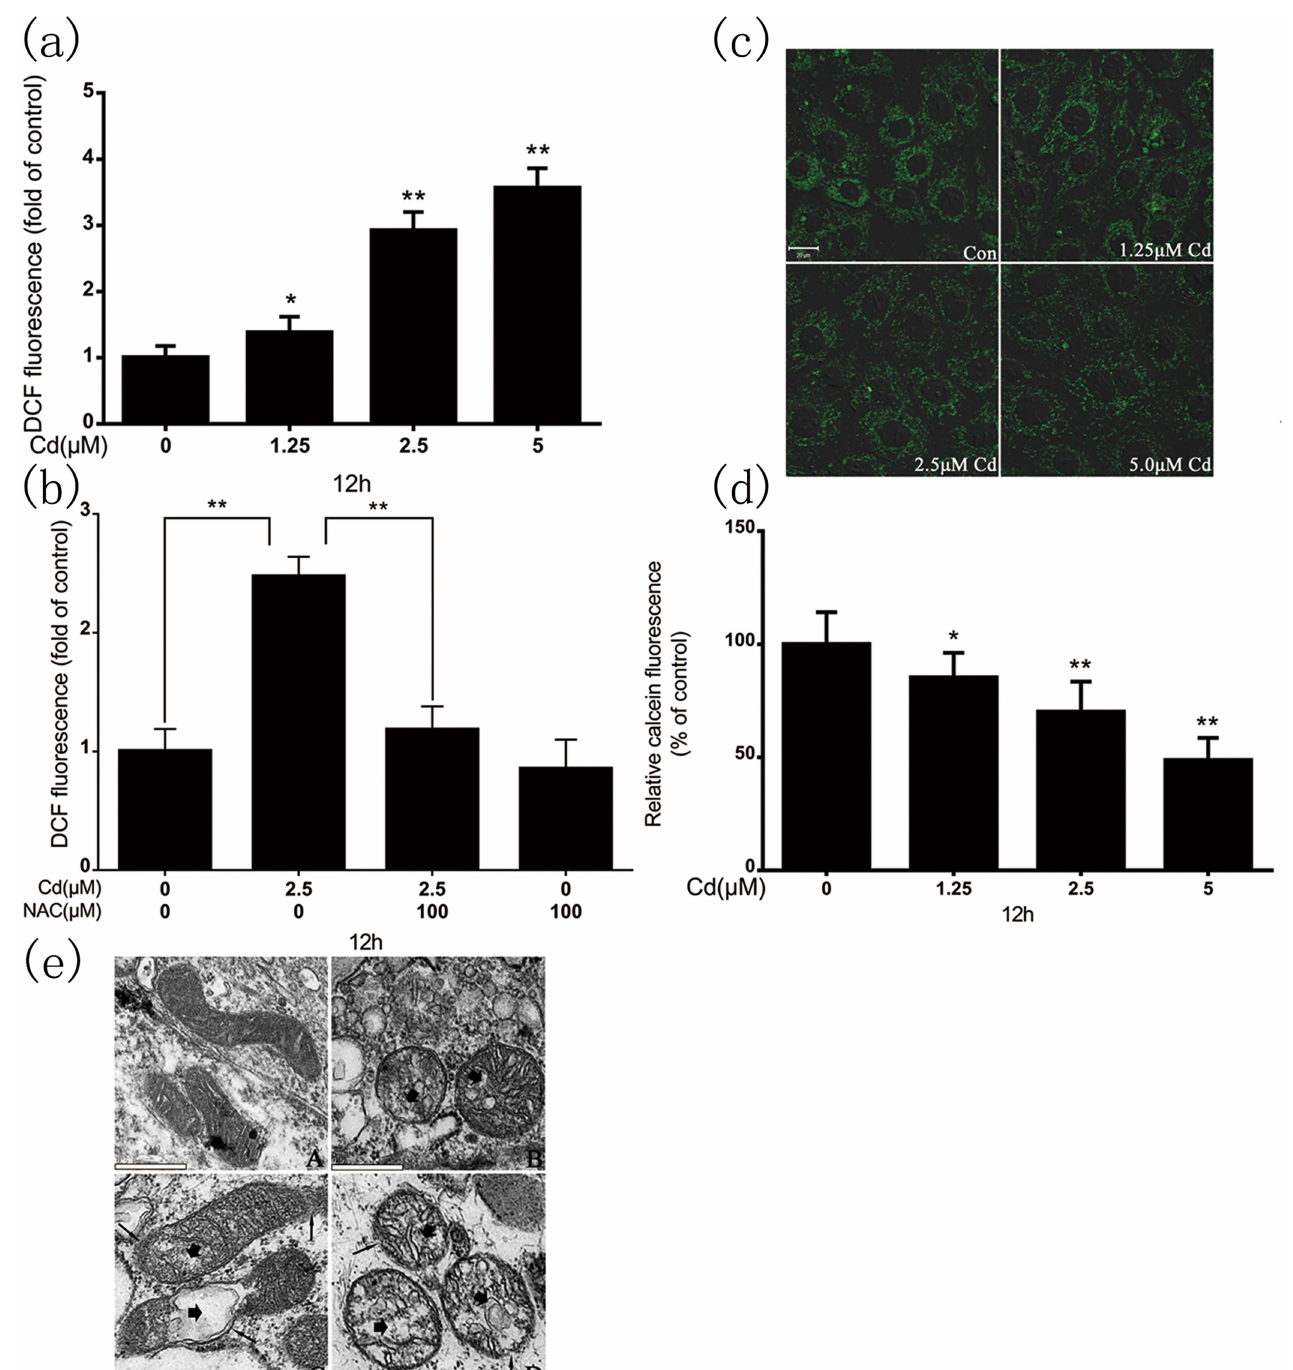
Fig 1. (a) Cadmium inducedROS generationdose-dependently in rPT cells. (b) Intracellular ROS levels in rPT cells after 12-h cadmium(2.5 μ M) treatment in the absenceor presence of NAC (100 μ M). DCF fluorescence was measuredusing a flow cytometer with FL-1 filter. Confocal microscopyof cadmium-inducedMPTP opening.(c) Representative confocalimages of cadmium-inducedrPT cells. (d) Quantification of calcein fluorescence. Calceinfluorescence values were quantifiedrelative to the control, where the fluorescence value was set at 100%. (e) Representative electron micrographs of rPT cell mitochondria followingcadmium exposure( × 6600magnification). Figure shows membrane disruption(thin arrows), swelling,and damagedcristae (thick arrows). Fluorescence results are expressedas mean fluorescence intensity, and are the mean ± SD of three separate experiments, each performed in triplicate (n = 9). * P < 0.05, ** P < 0.01 as comparedto control.